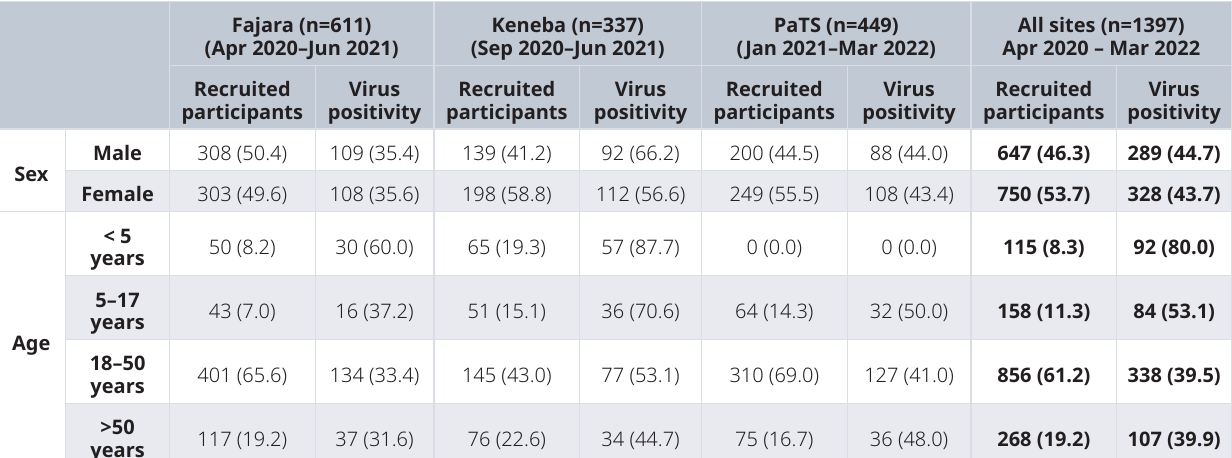
Table 1. Recruited participants and percentage with respiratory viruses detected stratified by recruitment site, age and sex. Total numbers are shown with % in brackets. The denominators for age and sex percentages are the total recruited numbers at each site or all participants combined. Virus positivity denotes detection of one or more viruses in the sample. The denominators for respiratory virus positive % are the total recruited within each sex or age strata for each study or all participants combined. The PaTS trial did not recruit any children below the age of 5 years.